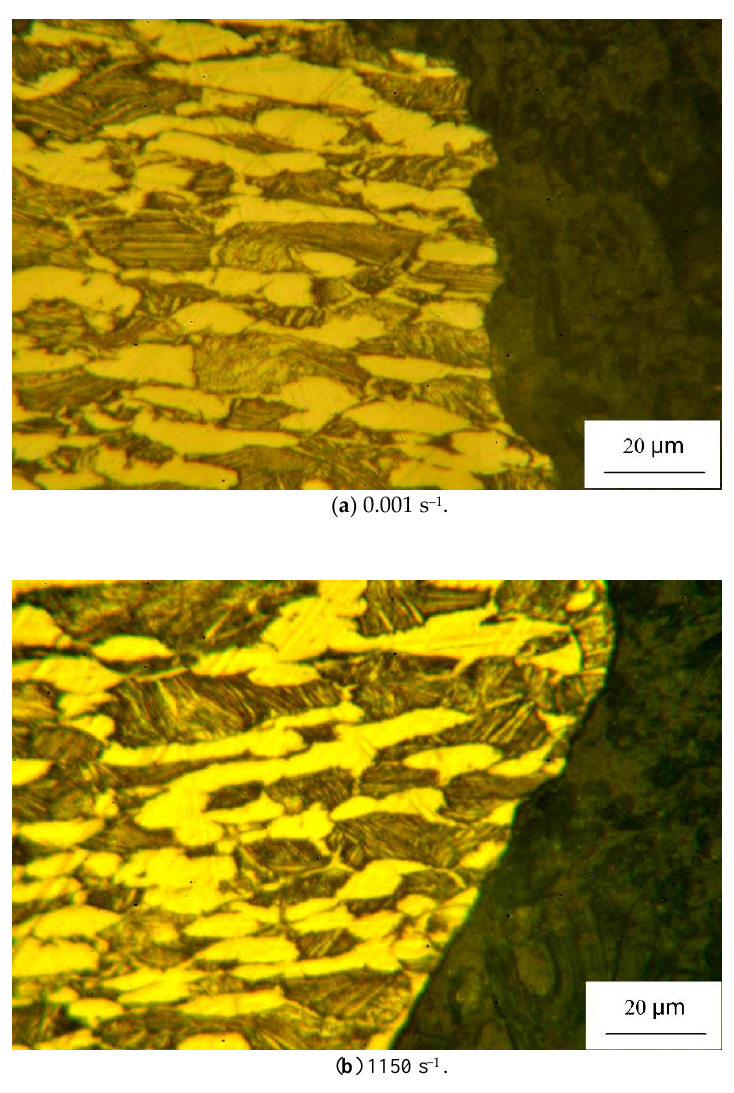
Figure 7. Metallographic examination of the deformed specimen at: ( a ) 10 − 3 s − 1 , ( b ) 1150 s − 1 .